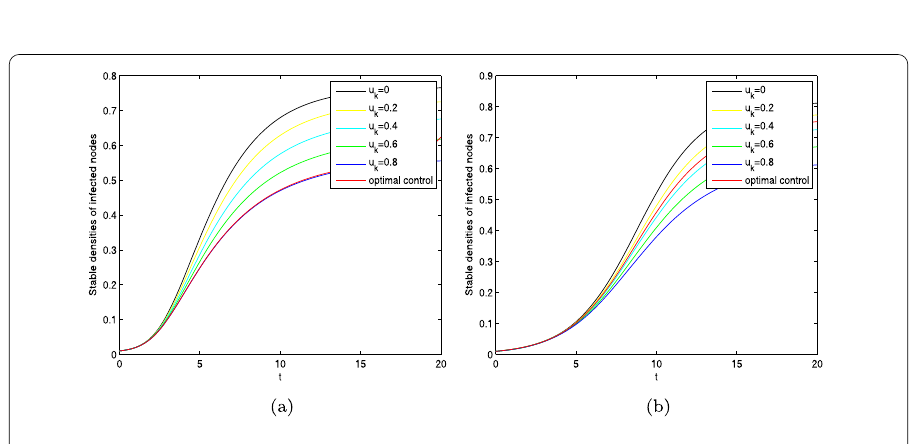
Figure 3 The average infected densities I = u k ( t ) = u and the optimal control u ∗